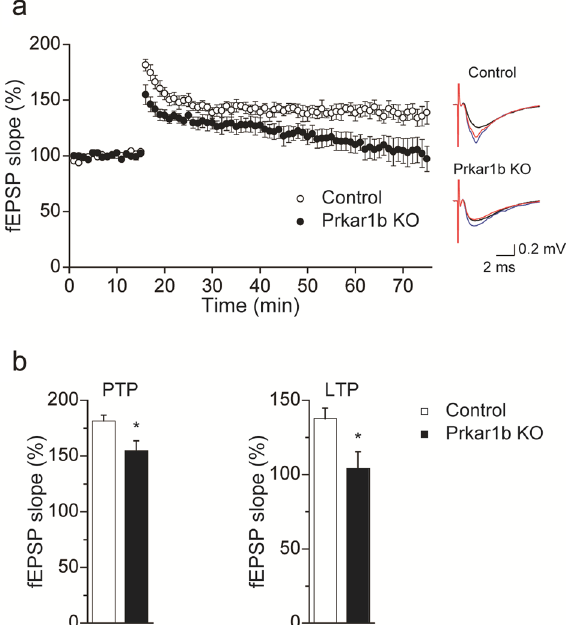
Figure 3. Impaired hippocampal synaptic plasticity at the Schaffer collateral–CAl synapse in Prkar1b -deficient rats. ( a ) Field potentials were recorded from the CA1 region of hippocampal slices from wild-type and Prkar1b - deficient rats. LTP was induced by theta burst conditioning stimulation (TBS). The slope of the EPSP relative to the pre-TBS level is plotted (wild-type, n = 6 slices from four rats; Prkar1b -deficient, n = 6 slices from three rats). Data are expressed as mean ± SEM. The inset traces show fEPSP at baseline (black), PTP (blue), and LTP (red) in wild-type (upper) and Prkar1b -deficient (lower) rats. ( b ) Changes of fEPSP amplitude compared with baseline. Regarding PTP at 1 min after TBS, the change observed in Prkar1b -deficient rats was significantly smaller than that in wild-type rats. Regarding LTP during 50–60 min after TBS, the change observed in Prkar1b -deficient rats was significantly smaller than that in wild-type rats. Data are expressed as mean + SEM. * P <